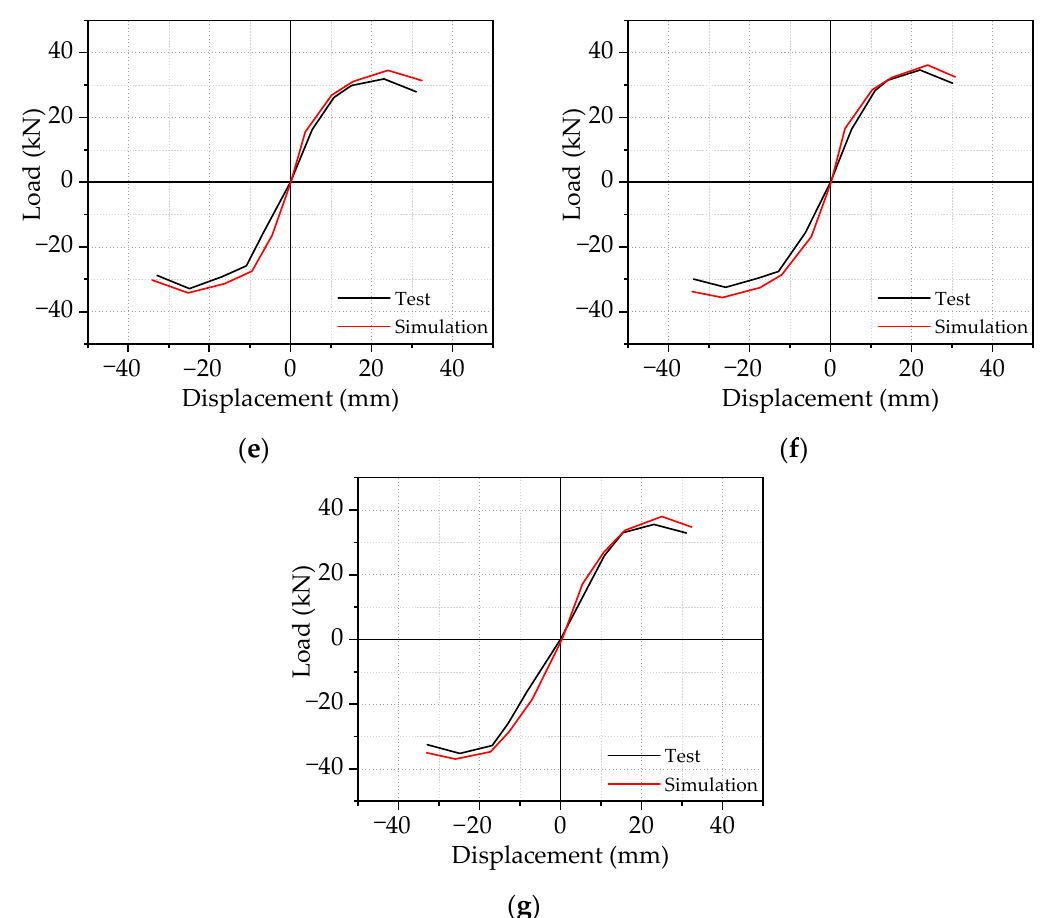
Figure 6. Comparison of skeleton curves of ( a ) BCJ0; ( b ) BCJ1; ( c ) BCJ2; ( d ) BCJ3; ( e ) BCJ4; ( f ) BCJ5; ( g ) BCJ6.